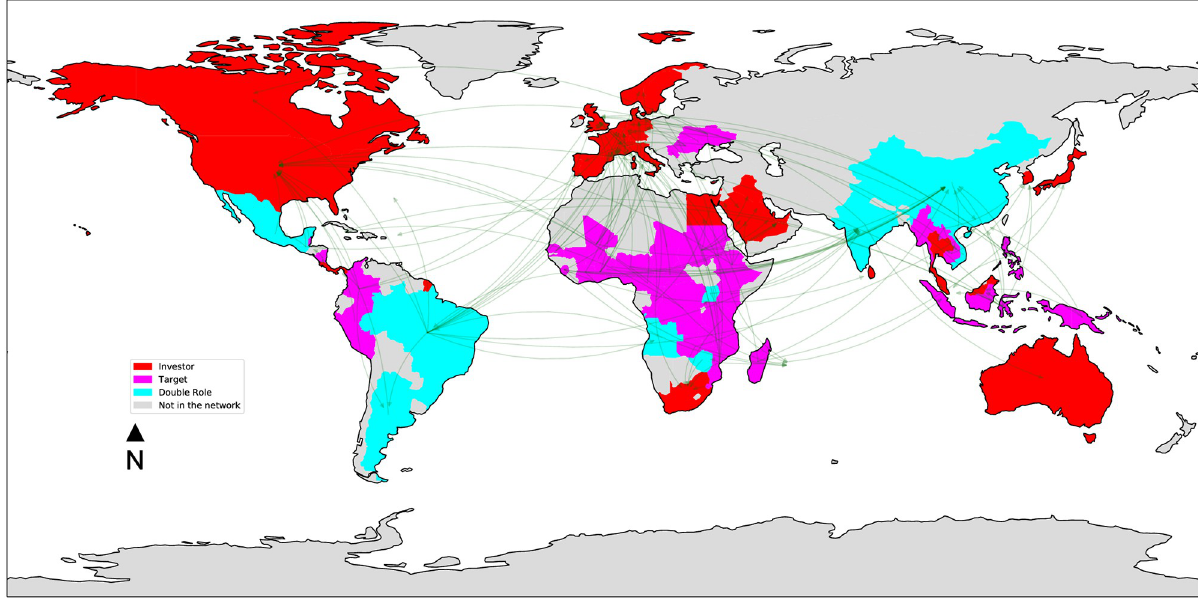
Fig 5. The biofuels land trade network, where countries are colored based on their role: Source nodes/pure investors (red), sink nodes/pure targets (magenta), double role countries (cyan). Countries colored in grey are absent from the network.